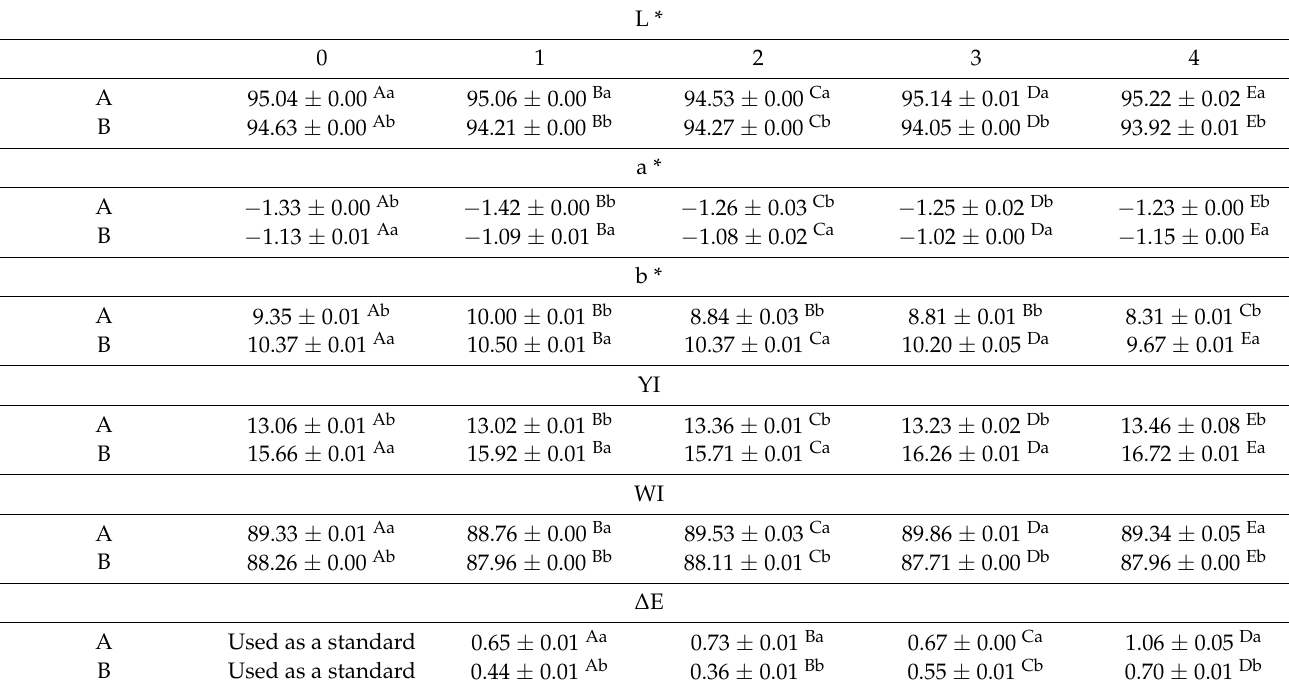
Table 2. Color changes of powders during